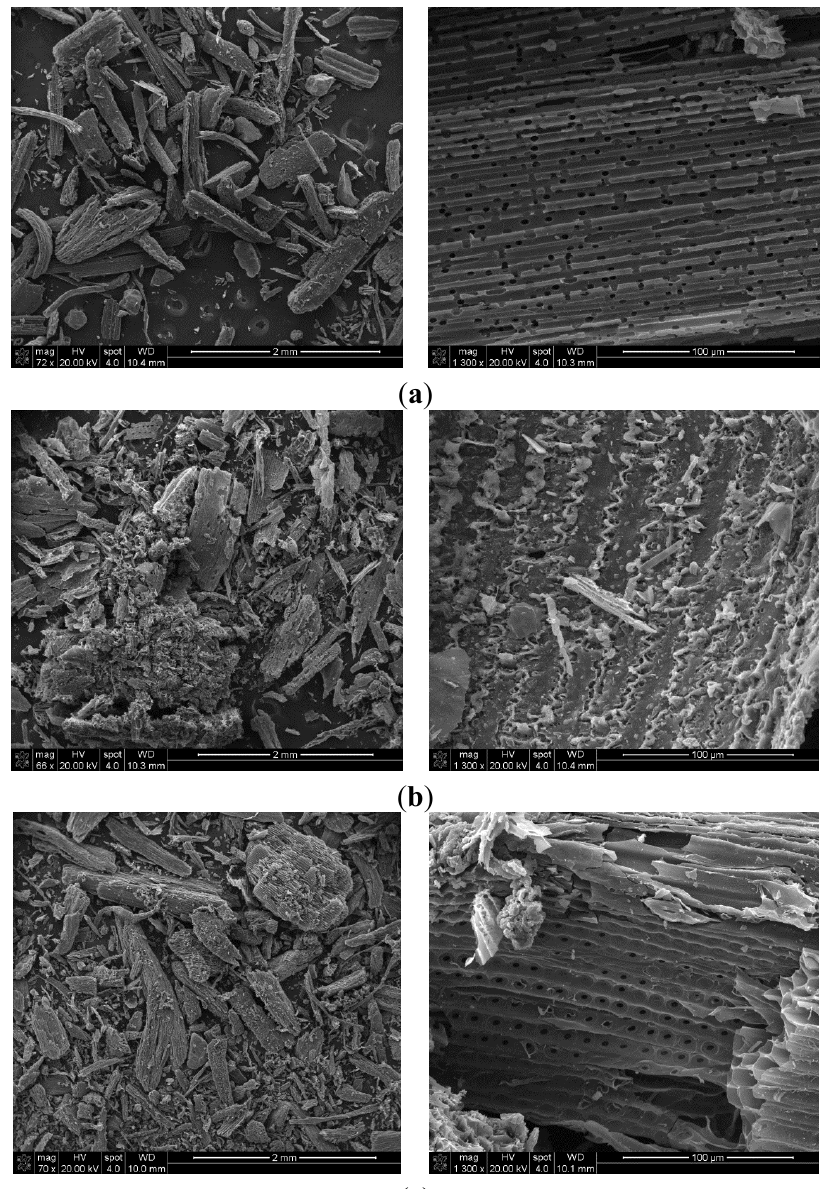
Figure 2. Scanning electron graphs of char at 0.28 equivalence ratio. From top to bottom is ( a ) switchgrass char, ( b ) sorghum char and ( c ) red cedar char. Magnifications of 72 and 1300 are shown on left and right,